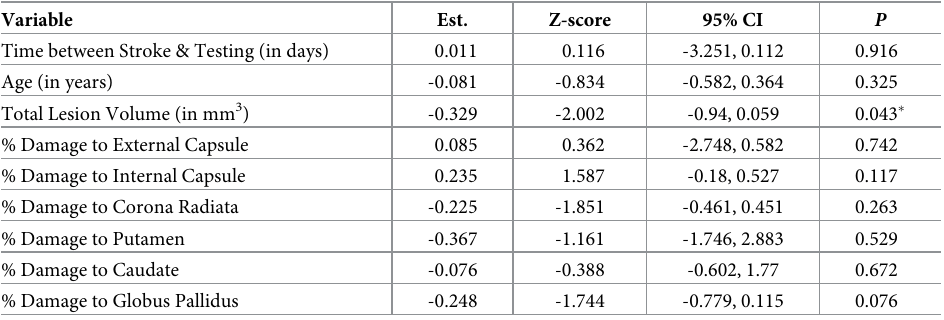
Table 2. LASSO regression predicting language summary z-scores from significant univariate predictors.